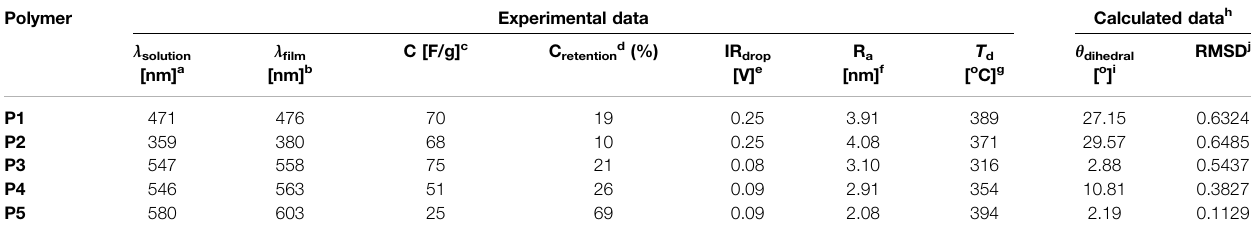
TABLE 1 | Physical, electrochemical, and conformational properties of P1 – P5 . Polymer Experimental